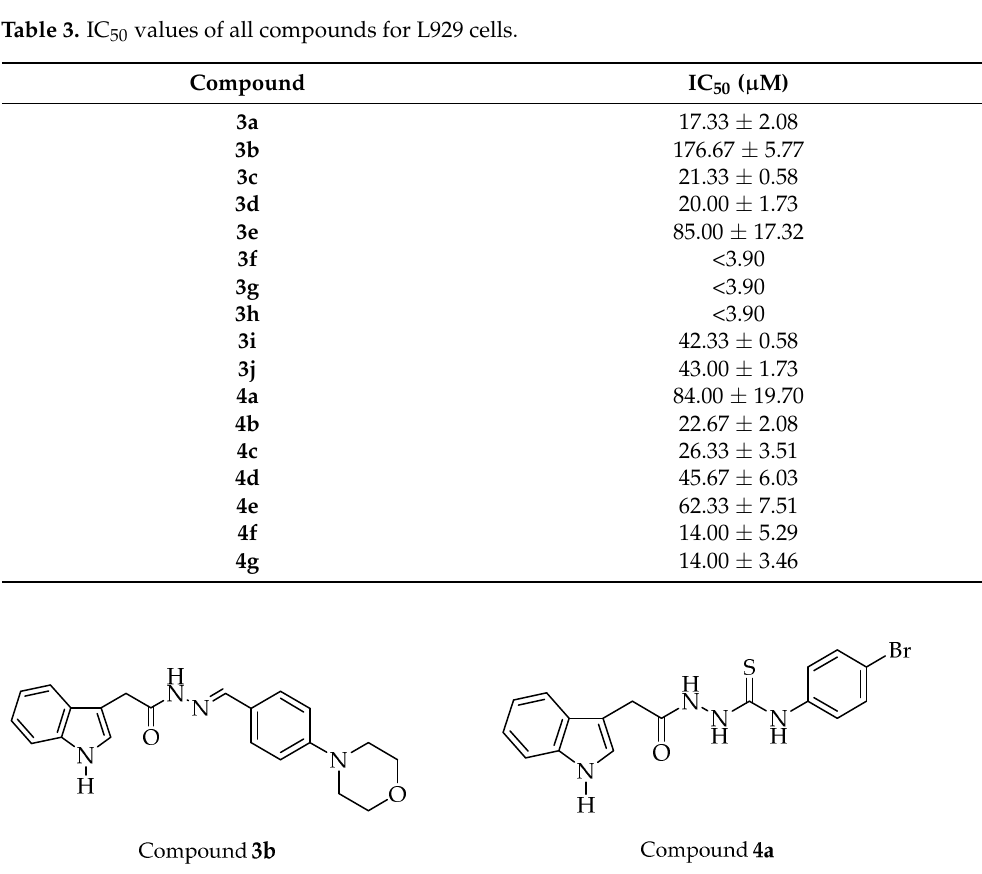
Figure 4. Selective COX-1 inhibitors in this series. Table 3. IC 50 values of all compounds for L929 cells.